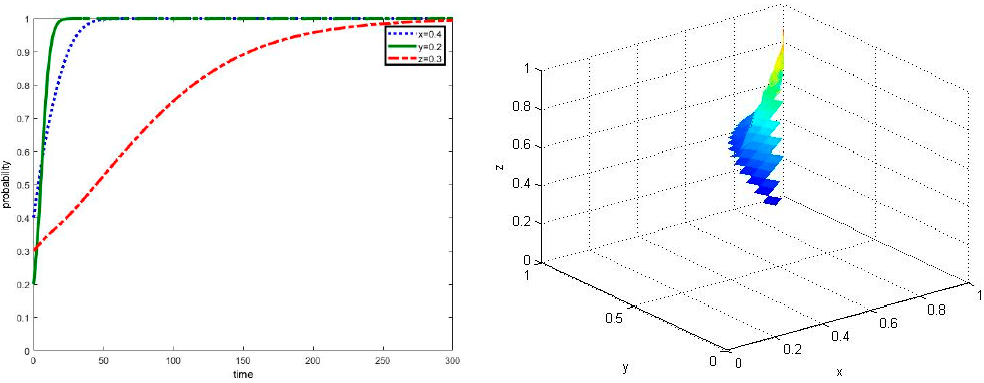
Figure 5. Simulation of dynamic evolution in the scenario of parameter α = 0.8. Int. J. Environ. Res. Public Health 2020 , 17 , x